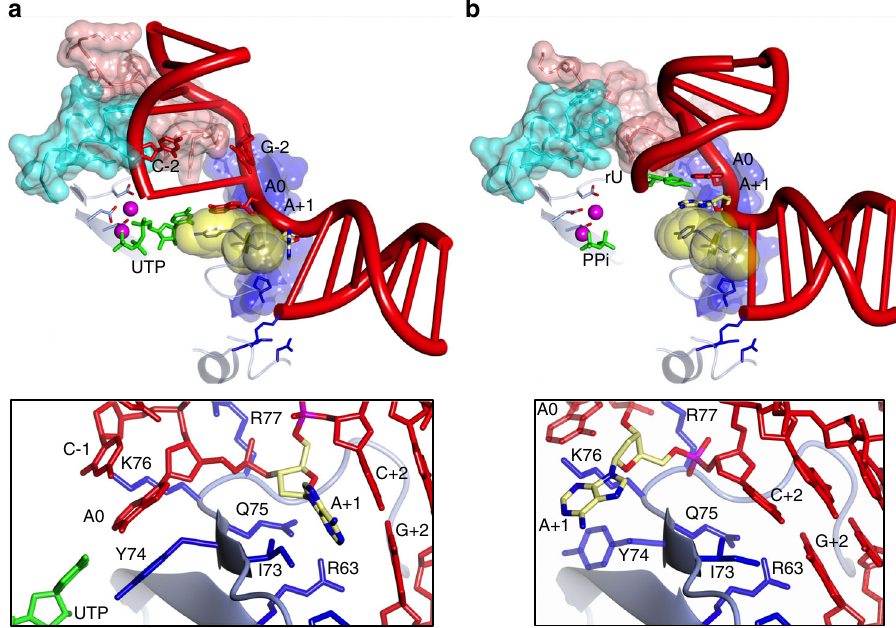
Fig. 6 Synthesis-dependent template displacement (STD) in fl uences DNA conformation through direct interactions between the gap and a hydrophobic wedge. a A schematic representation of the Prim – PolC/DNA/UTP ternary model emphasising how the splaying of the template strand and bases in the gap is in fl uenced by a hydrophobic wedge (I73/Y74). Surface loops (1 – 3) also play key roles in orientating the upstream side of the gapped DNA. Loops 1 – 3 are represented as translucent surfaces coloured blue, salmon and cyan, respectively. The base pairing of the upstream DNA is disrupted at G/C-2 by interactions with Loop 3. The surface of I73/Y74 wedge is coloured yellow. The inset view (below) shows the side-chain interactions that participate in the splaying of the gap bases (A0 and A + 1) of the template strand. b A similar schematic representation of the post-turnover complex with PPi bound in the active site. This structure shows a signi fi cant difference in the bending angle and orientation of the upstream DNA following synthesis brought about by the change in splaying angle around the wedge and loss of contacts with Loops 2 and 3, induced by synthesis-dependent template displacement. The surface of I73/Y74 wedge is coloured yellow. The inset view (below) shows the relocation of the second gap base (A + 1) across the wedge into the active site following ribonucleotide incorporation opposite A0. Side chains with poor density are represented as transparent